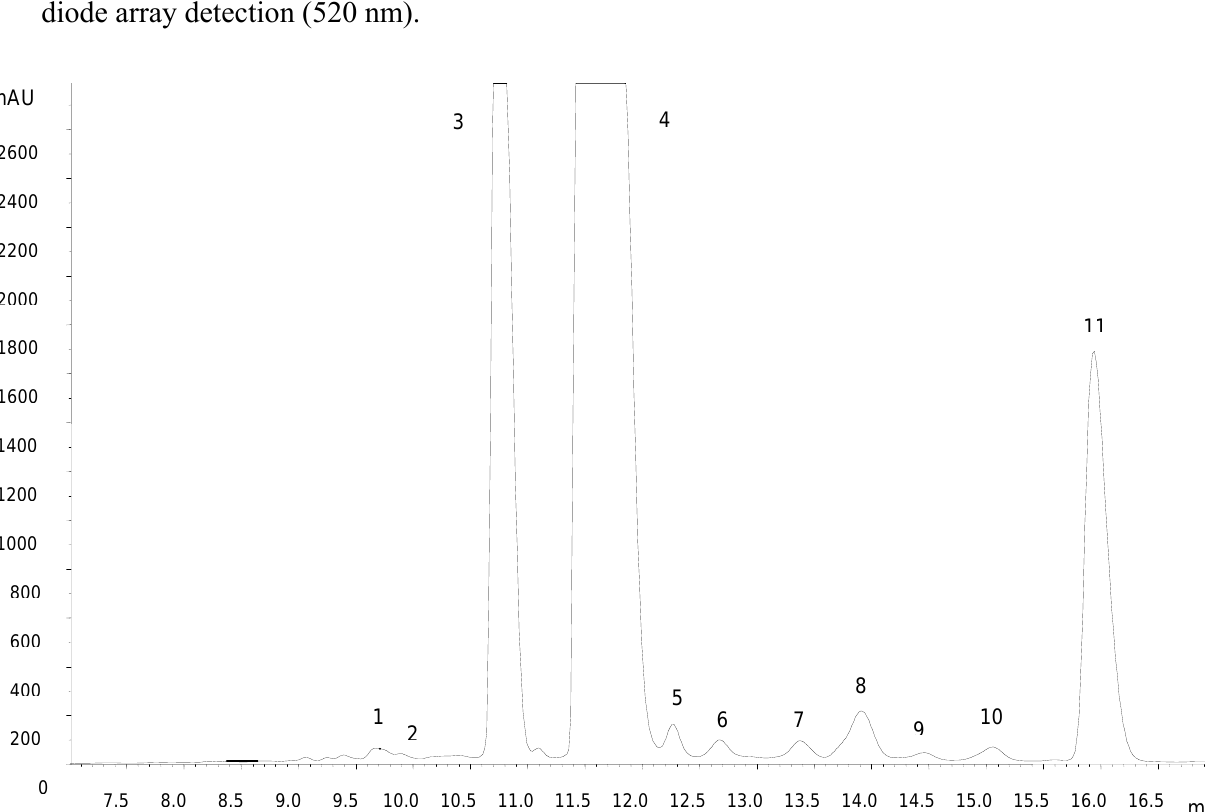
Figure 1. Separation of anthocyanins extracted from Amazon grape peels by HPLC with diode array detection (520